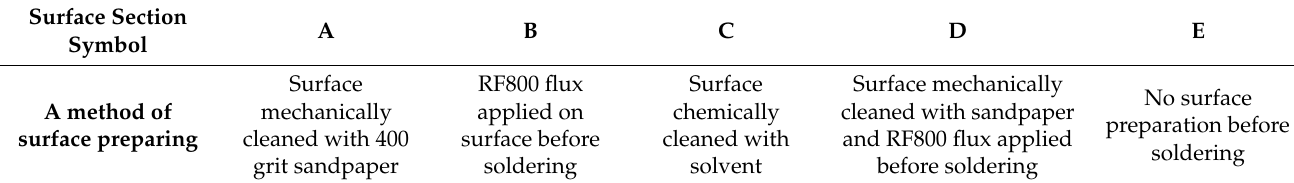
Table 1. List of preparation methods of the composite surfaces before